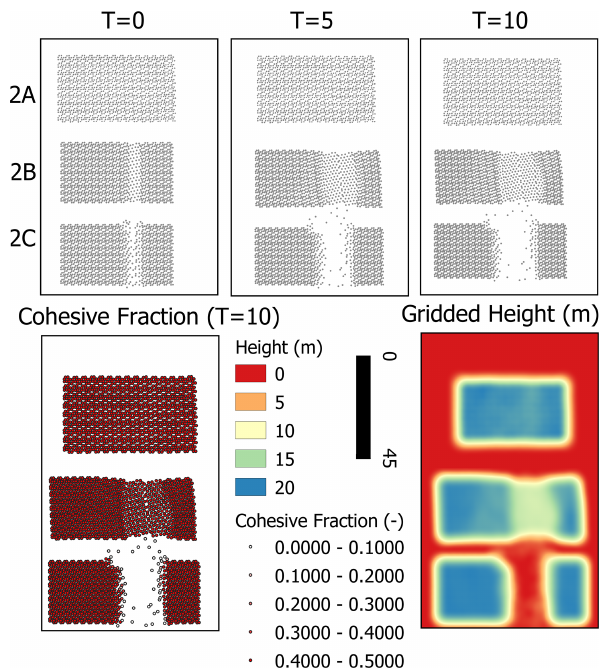
Figure 7. Several time slices for numerical scenarios 2A, 2B and 2C. See Fig. 6 for the dimensions and terrain